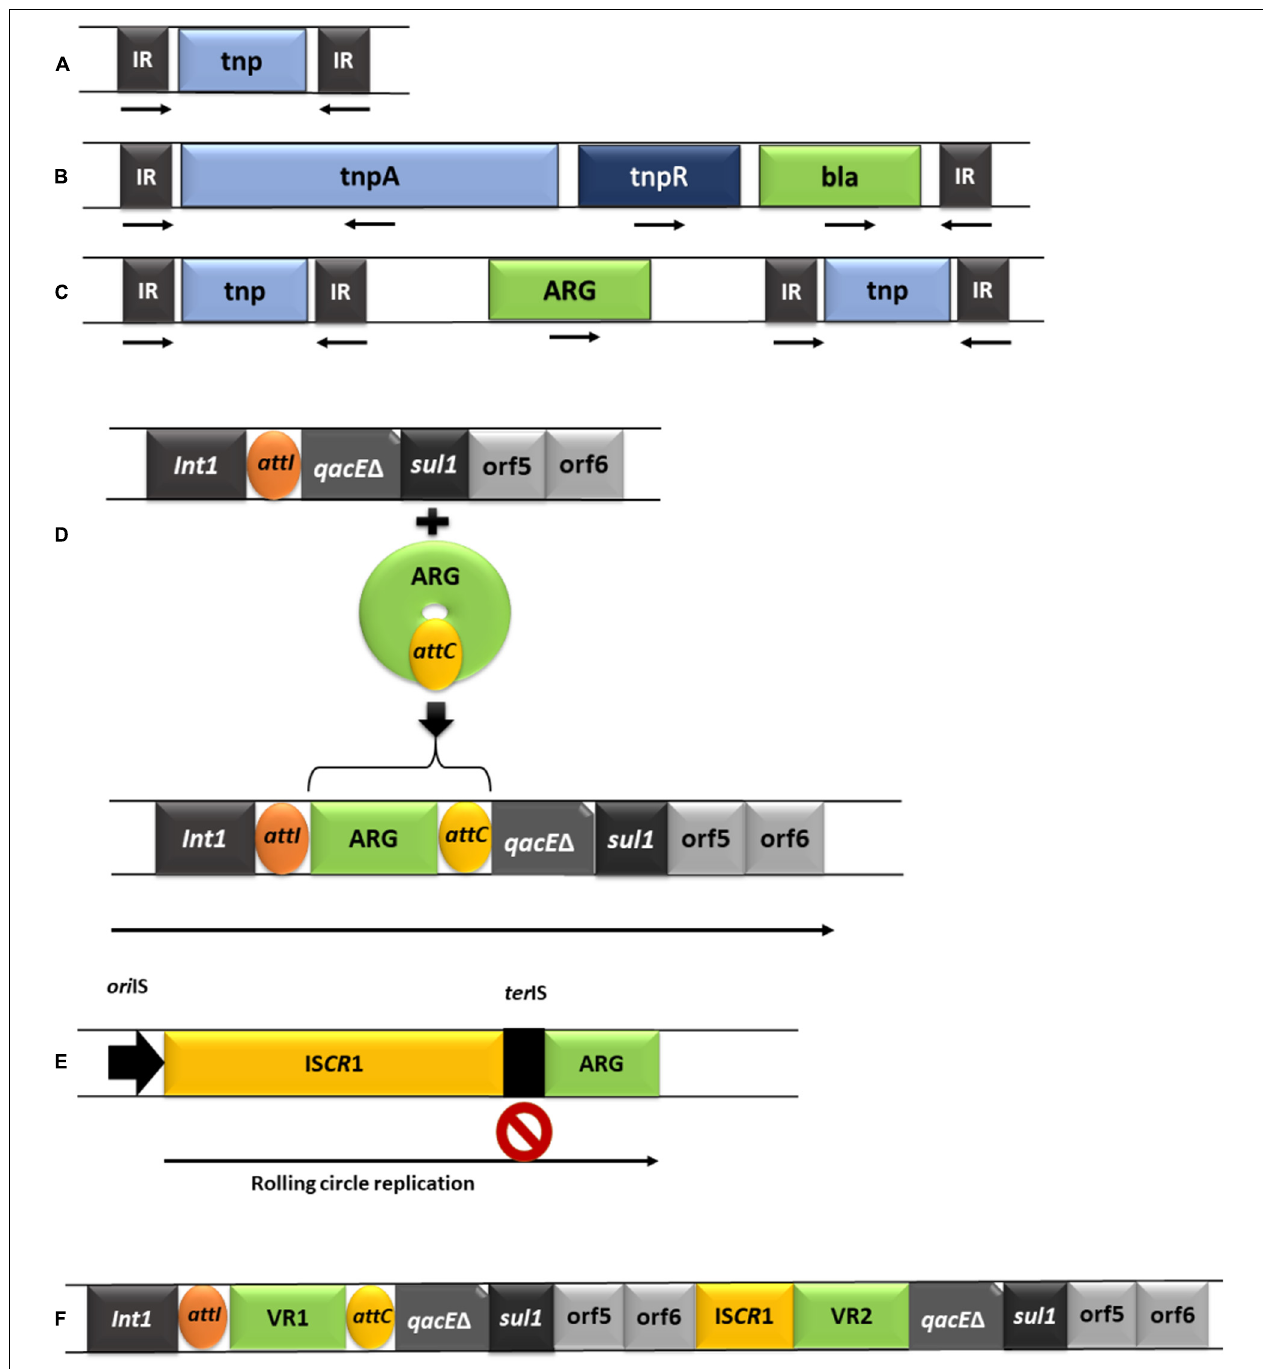
FIGURE 2 | Schematic representation of the predominant MGEs involved in acquisition and dissemination of ARGs. (A) , IS element (IR: inverted repeats; tnp : transposase gene). (B) , Tn 3 complex transposon ( tnp B: resolvase gene; ARG-antibiotic resistance gene). (C) , composite transposon. (D) , class I integron and the acquisition of a gene cassette ( Int 1: integrase gene; att 1: recombination site of the integron; qac E δ : truncated segment belonging to a gene that encodes resistance to quaternary ammonium compounds; sul1: sulfonamide resistance gene; orf 5/ orf 6: open reading frames, att C: recombination site of the gene cassette). (E) , the mechanism of acquiring adjacent DNA by ISCR elements ( ori IS: origin of replication; ter IS: end of replication; a second stop sign is located after the ARG, allowing transposition of the entire segment by recombination). (F) , complex class 1 integrons (Int1: integrase gene, followed by the att I site; VR1/VR2: variable regions e.g., ARGs, followed by the att C